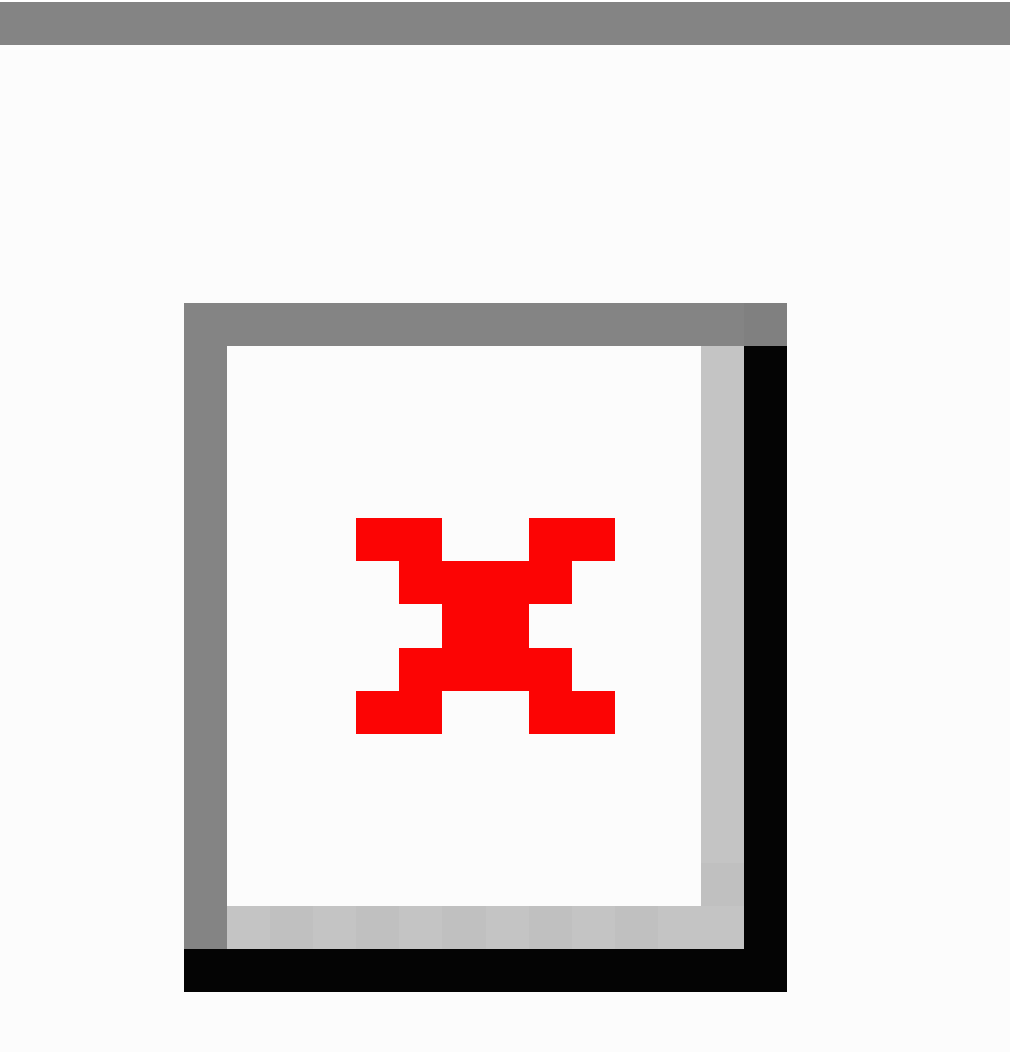
Figure 5. Step count versus circadian time for functionally intact (blue) and frail (red) individuals. Bars are plus or minus one standard error of the mean. Time values given in military